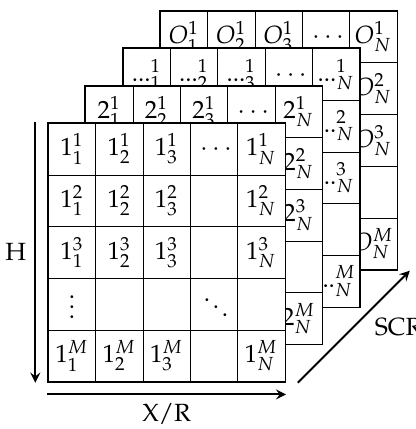
Figure 12. Matrix indices from sweeping SCR, X/R, and H. To evaluate the performance, the arrays were reduced to two-dimensional